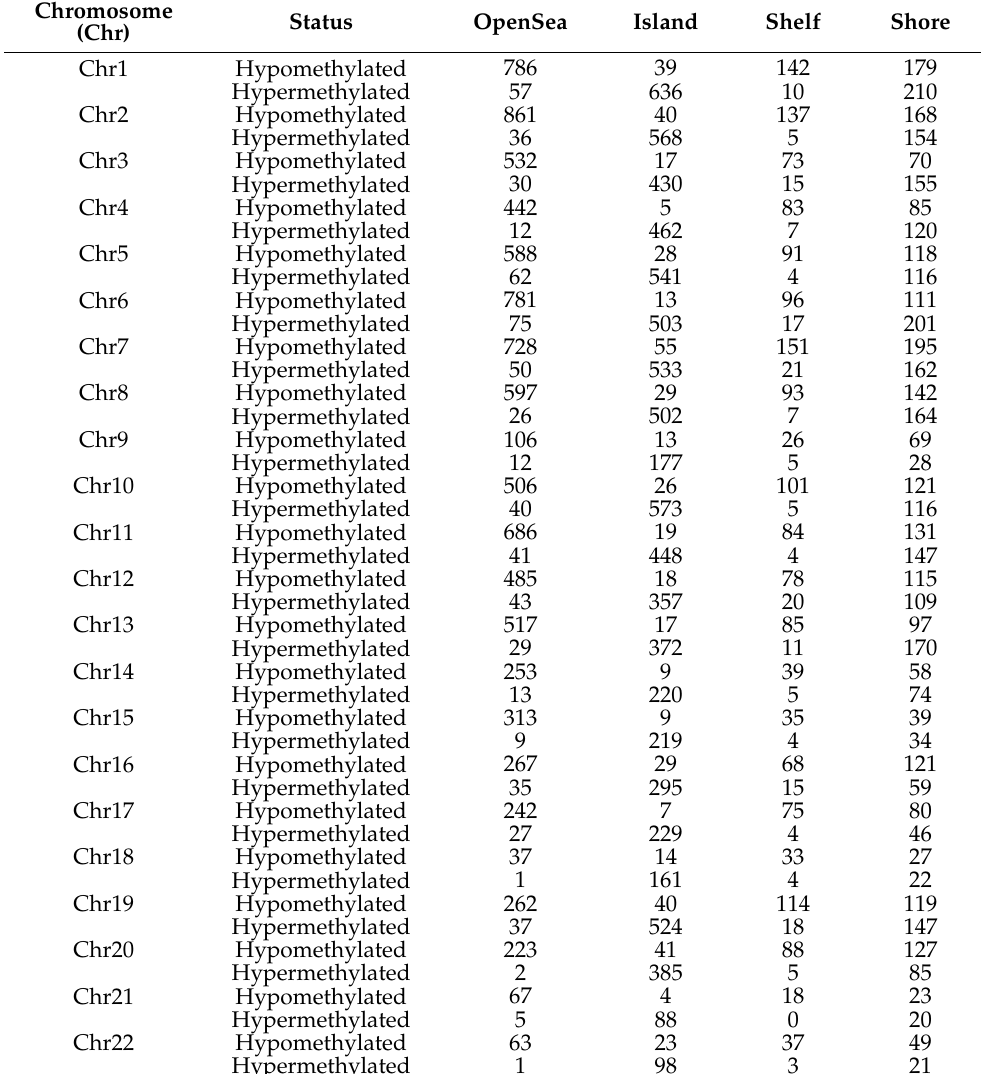
Table 1. Overview of genome-wide methylation burden across all chromosomes. The number of hypermethylation and hypomethylation events in relation to CpG islands and neighborhood regions are given. Chromosome